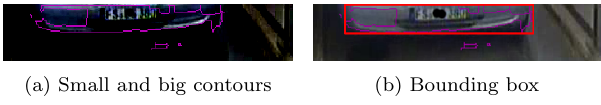
Figure 3: Contour finding process